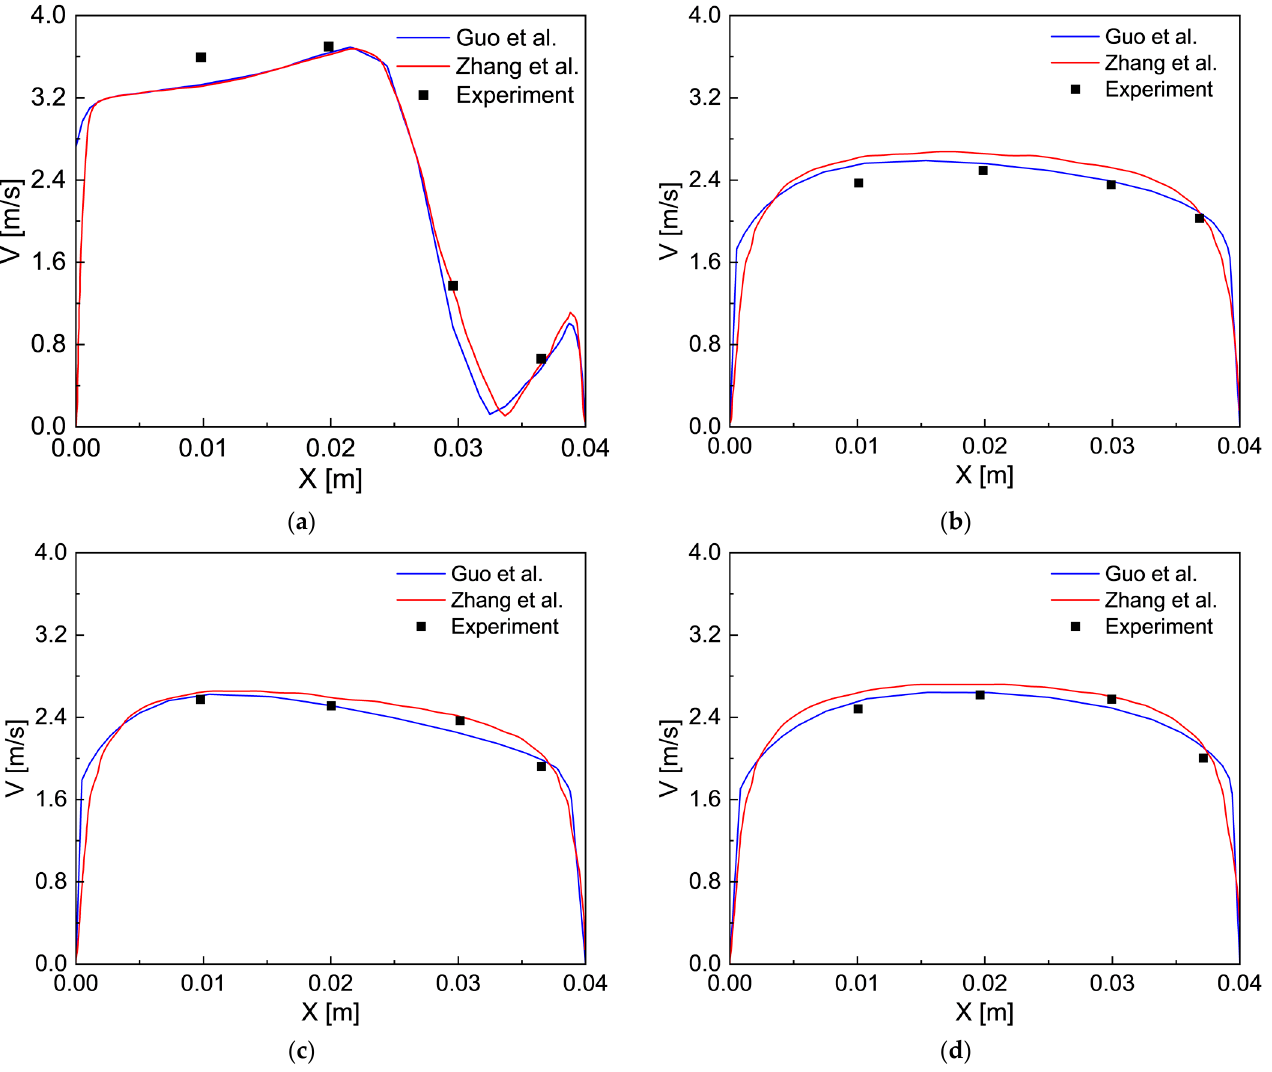
Figure A2. Air speed comparison between experiments and simulations: ( a ) H = 0.02m; ( b ) H = 0.54 m; ( c ) H = 0.80m; ( d ) H = 1.06 m. (Symbols for experimental values, and lines for simulation results).